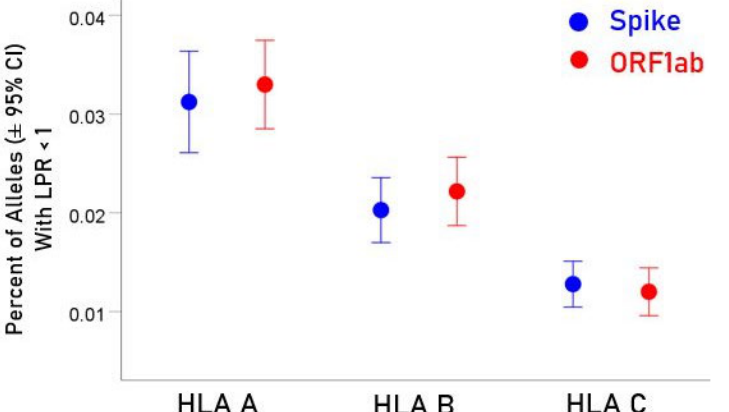
Figure 4. Mean percentages (± 95% CI) of alleles with LPR < 1 for the 3 genes and 2 proteins. See text for details of statistical